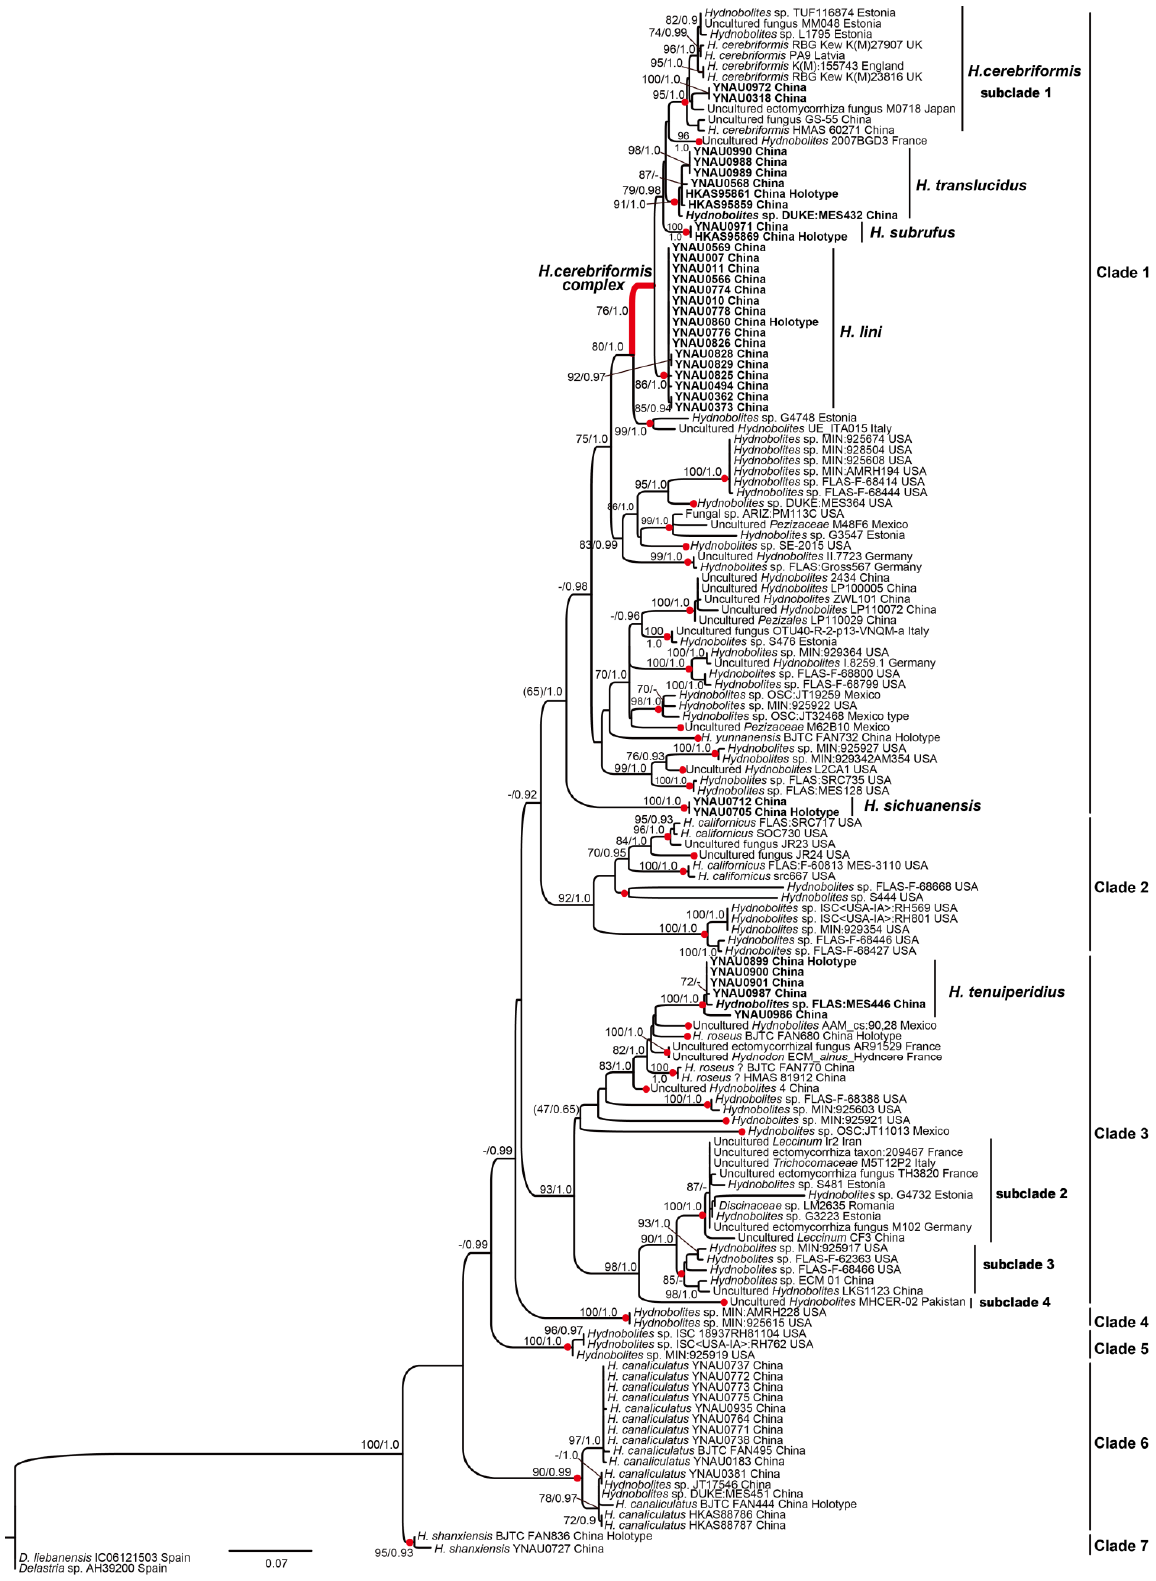
Figure 1. The consensus phylogram of the Genus Hydnobolites obtained in RAxML of ITS rDNA. Nodes were annotated if supported by > 70% ML BP or > 0.90 Bayesian PP, but non-significant support values are exceptionally represented inside parentheses. New species are in bold font. Complex is reported as red thick branch.